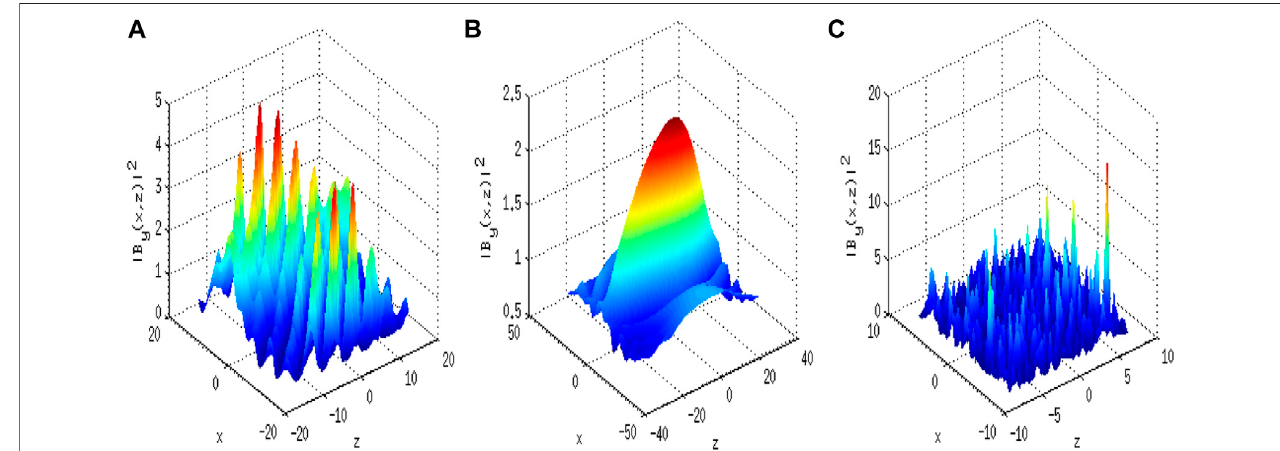
FIGURE8 | Normalizedmagnetic fi eldintensity ofwave (| B 2 y | / B 2 n ) in anormalized x – z plane ( x normalized with x n (cid:2) ρ s and z normalized by z n (cid:2) 2/ k 0 z ) withIC-3 for (A) α